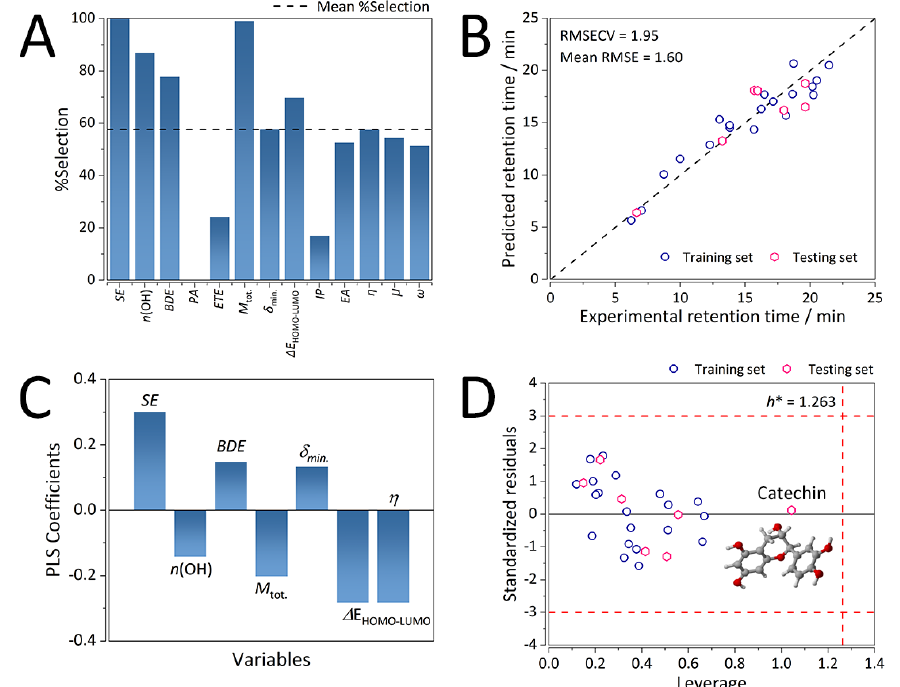
Figure 4. Performance characteristics of the consensus GA-PLS QSRR model for the IAM.PC.DD2 column. ( A ) Occurrence (expressed through % of selection) of molecular descriptor selection in 1000 GA-PLS runs. ( B ) Predictive ability on the training and validation sets ( n = 27). ( C ) Distribution of the PLS coefficients (intercept = 0, due to autoscaling). ( D ) Applicability domain computed on the training and testing sets (n = 27). Warning limits: three multiples of the standard deviation of standardized residuals, and critical leverage ( h *) of 1.263. Royal blue circles depict the training set observations, whereas the pink diamonds depict the testing set observations.